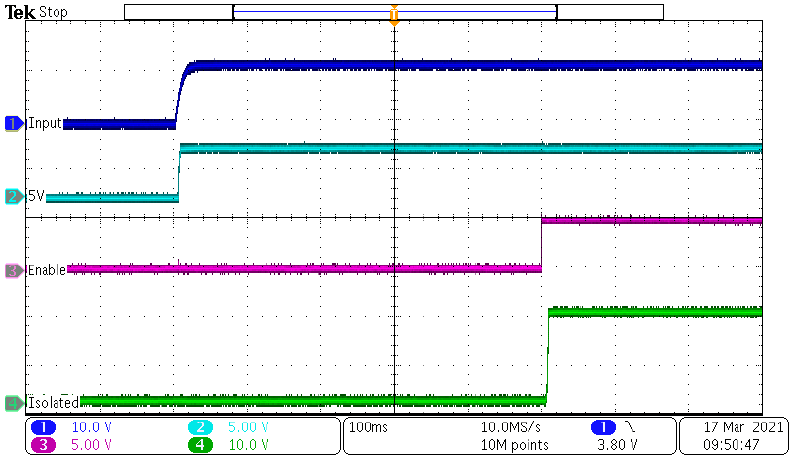
Figure 12. The temperature of the isolated power supply at the load of 2 W. After the power supply efficiency and maximum load temperature, the most important indicator of the power supply quality is the output voltage waveform, especially during the startup of the power supply and dynamic events. If the overvoltage occurs during the startup, this can lead to the destruction of the semiconductor components. Thus, measuring the quality of the output waveform is important. The waveform of all of the voltages during the converter power supplies startup sequence can be seen in Figure 13.